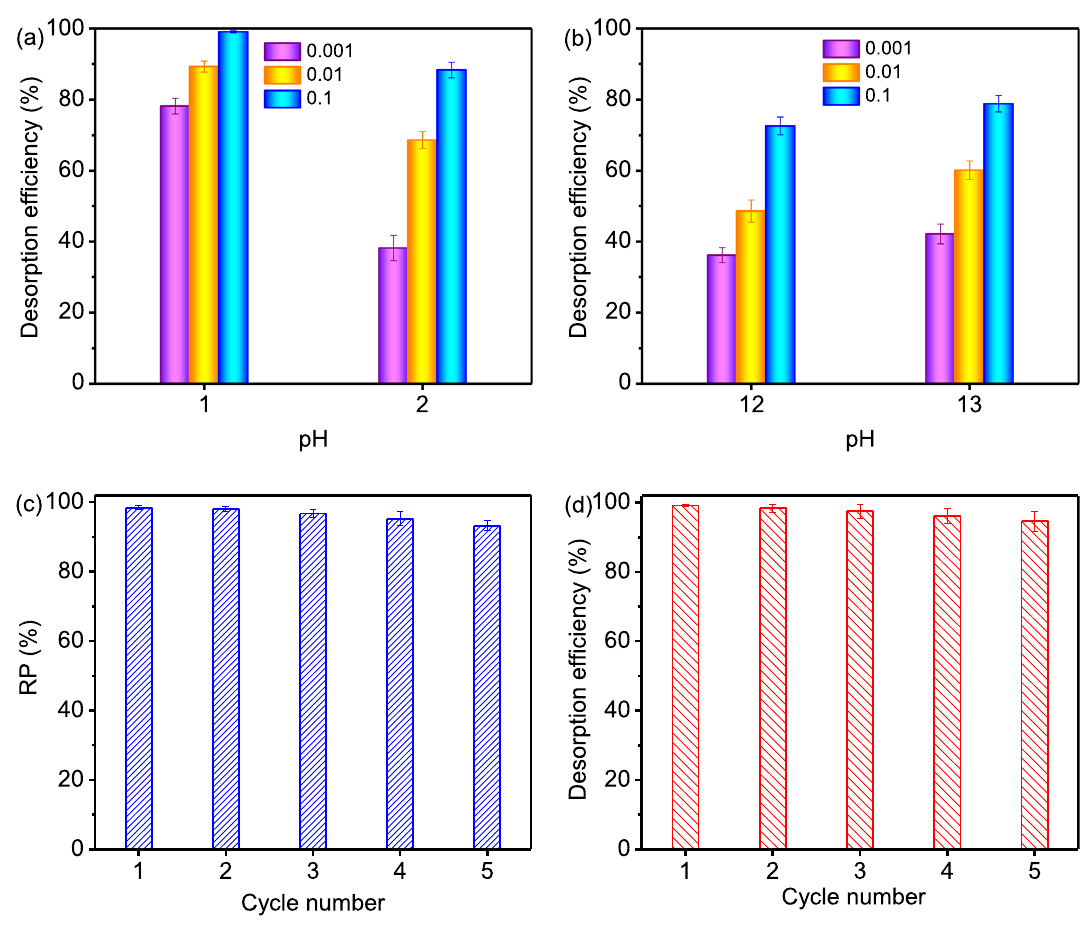
Fig. 7 a Effect of CaCl c Removal percentage of U(VI) on Hap@BC-10% for five cycles 2 concentration in acidic solution on desorp- (C i = 5 mg/L, pH = 3, m/V = 0.1 g/L and T = 298 K) and d Desorption tion efficiency of Hap@BC-10%-U, b Effect of CaCl 2 concentration in alkaline solution on desorption efficiency of Hap@BC-10%-U, efficiency of U(VI) on Hap@BC-10%-U for five